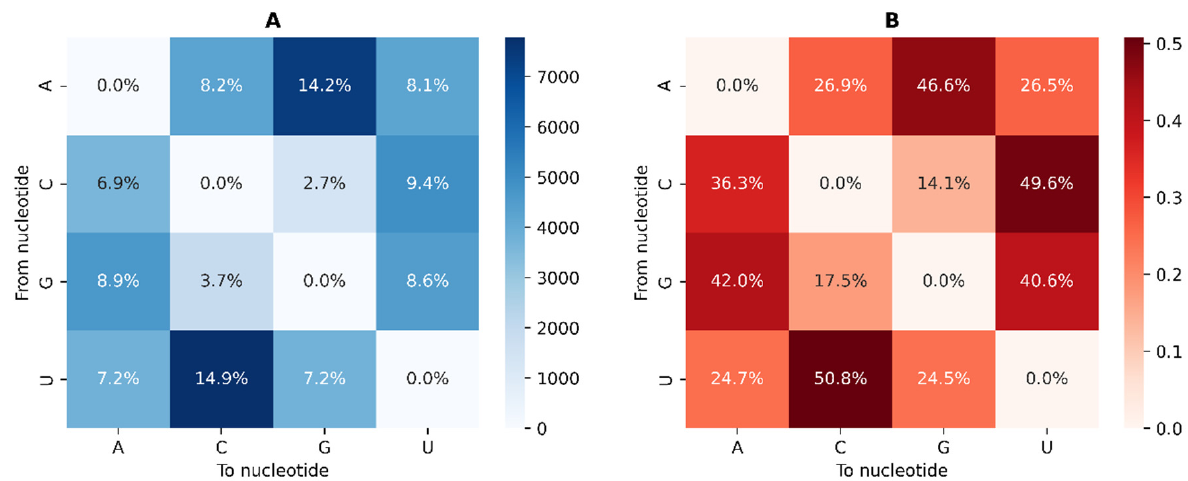
Figure 1. Nucleotide change count of unique single nucleotide mutations. ( A ) Total count of changes among unique mutations. ( B ) Nucleotide change normalized through the horizontal axis. Each row adds up to 1.